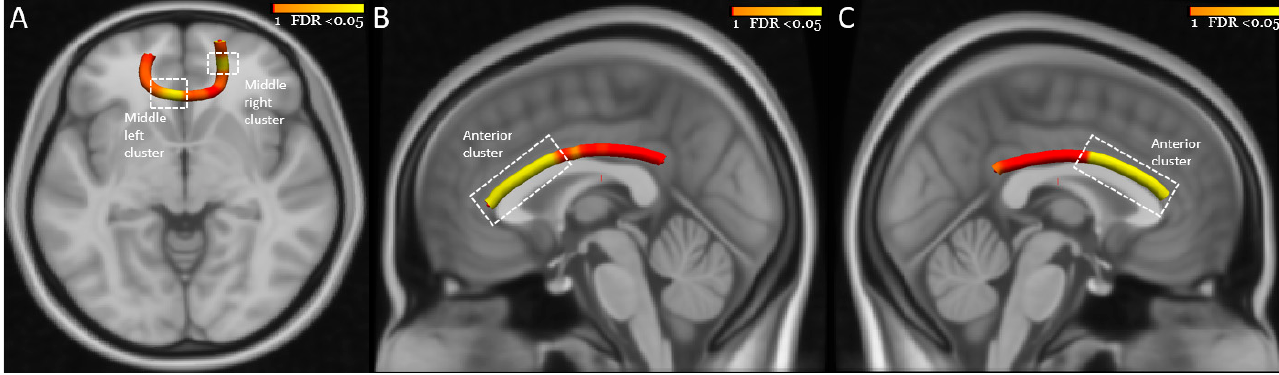
Figure 2. Neural correlates of previous bipolar illness. ( A – C ) show the node clusters in the FMIN, left CB, and right CB. Tracts were reconstructed using Tracula. The background is the standard MNI-152 1 mm brain. The red-yellow color bar represents the range of p values used in node-wise statistics after FDR correction. Abbreviations: FMIN, Forceps Minor; CB, Cingulum Bundle.